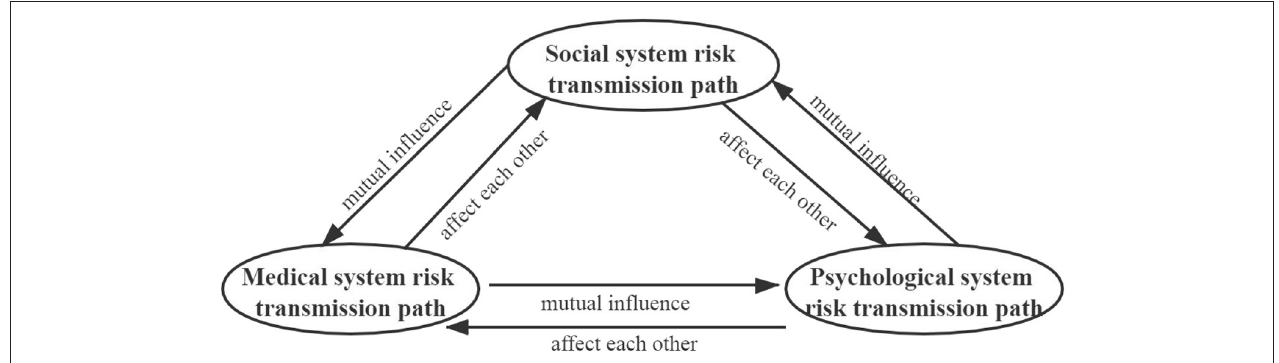
FIGURE 3 | Coupling structure of the epidemic risk transmission